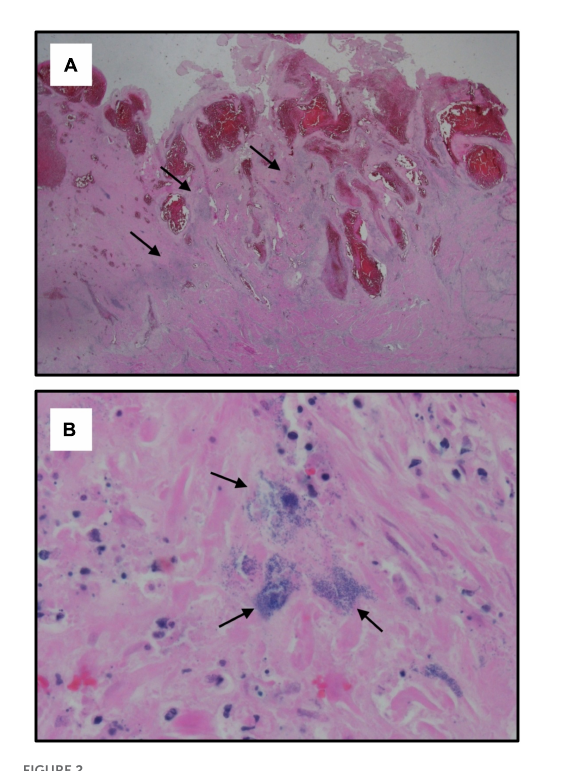
FIGURE2 Histological specimens of the uterus. Microscopic examination of the uterus showing: (A) Hypertrophic post-partum uterus with acute inflammatory process characterized by extensive areas of recent hemorrhage and dilated congested vessels of the placental site. Black arrows indicate the focus of necrotic myometrium with bacterial colonies (hematoxylin and eosin staining, X1.25); (B) Acute inflammation with necrotic myometrium. Black arrows indicate bacterial colonies (hematoxylin and eosin staining,